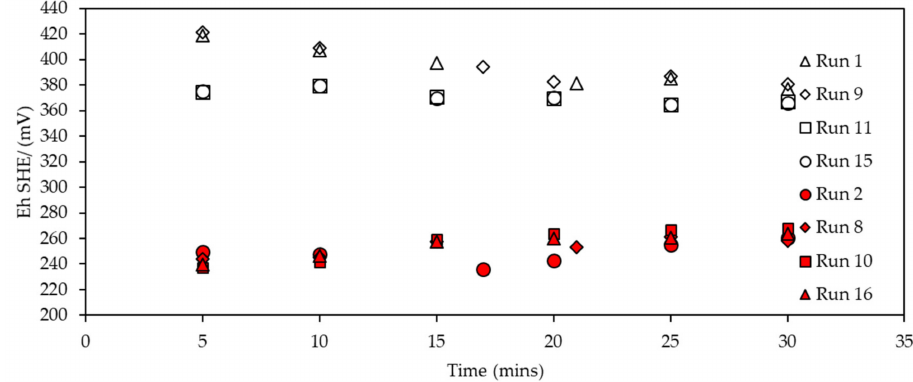
Figure 5. Plot of Eh vs. time for various conditions of collector adsorption on enriched pentlandite. No Fill (5 ◦ C); Fill (65 ◦